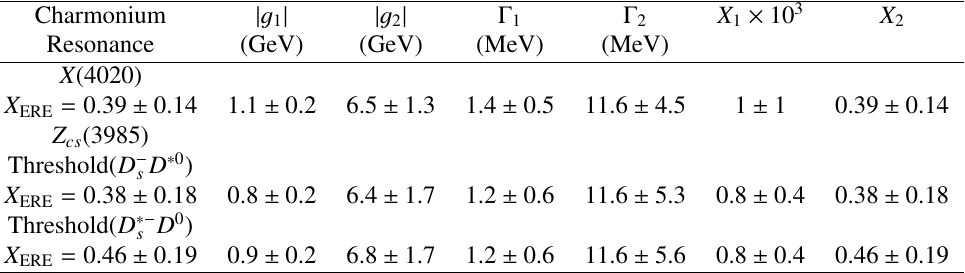
Table 3. The coupled-channel solutions for the X (4020) and Z cs